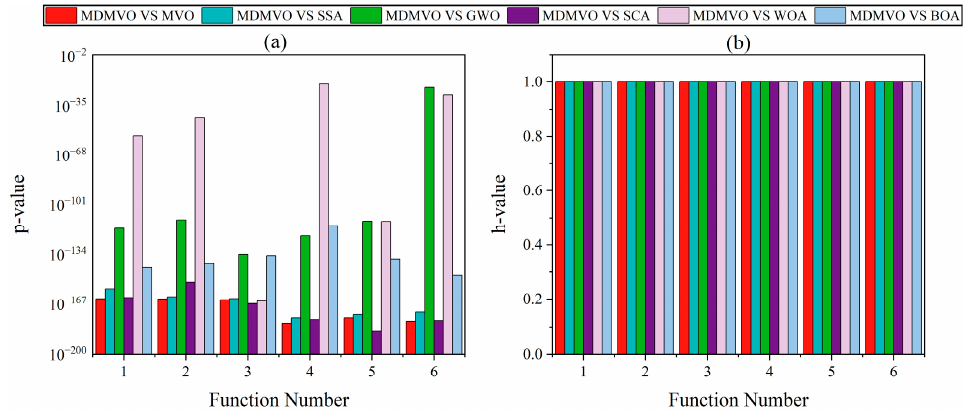
Figure 10. Wilcoxon rank-sum test for MDMVO compared with the other six techniques: ( a ) p - value and ( b ) h - value .